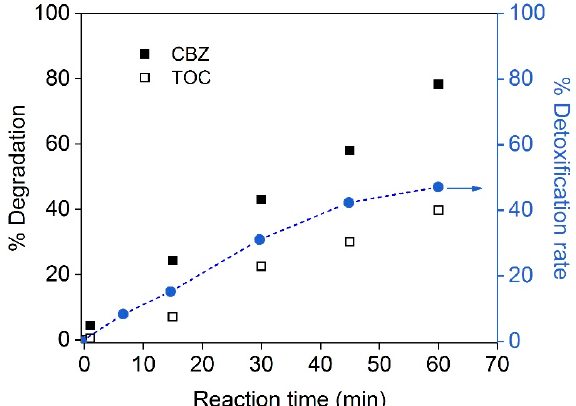
Figure 10. The toxicity evolution of CBZ solution degraded by PMS/BiOBr process. BiOBr dose 0.5 g ∙ L − 1 , [CBZ] 0 = 40 μ M, [PMS] 0 = 4.0 mM, pH = 7.0, T = 24 °C.